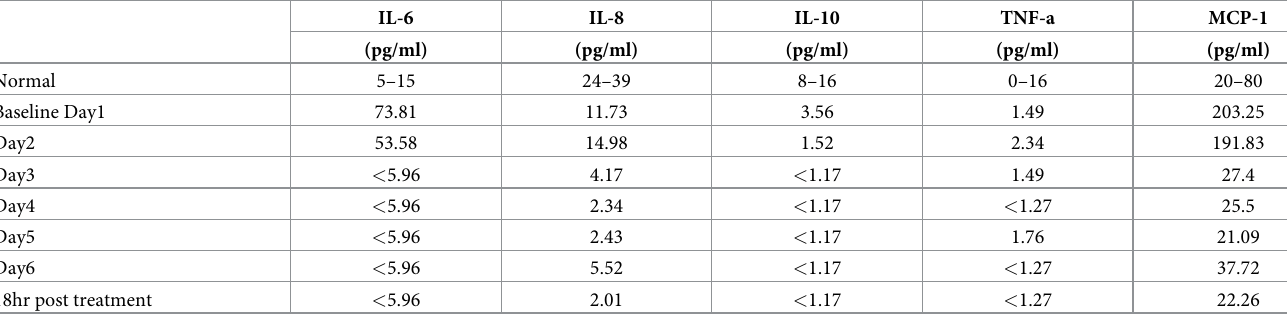
Table 4. Serum cytokine levels and SCD